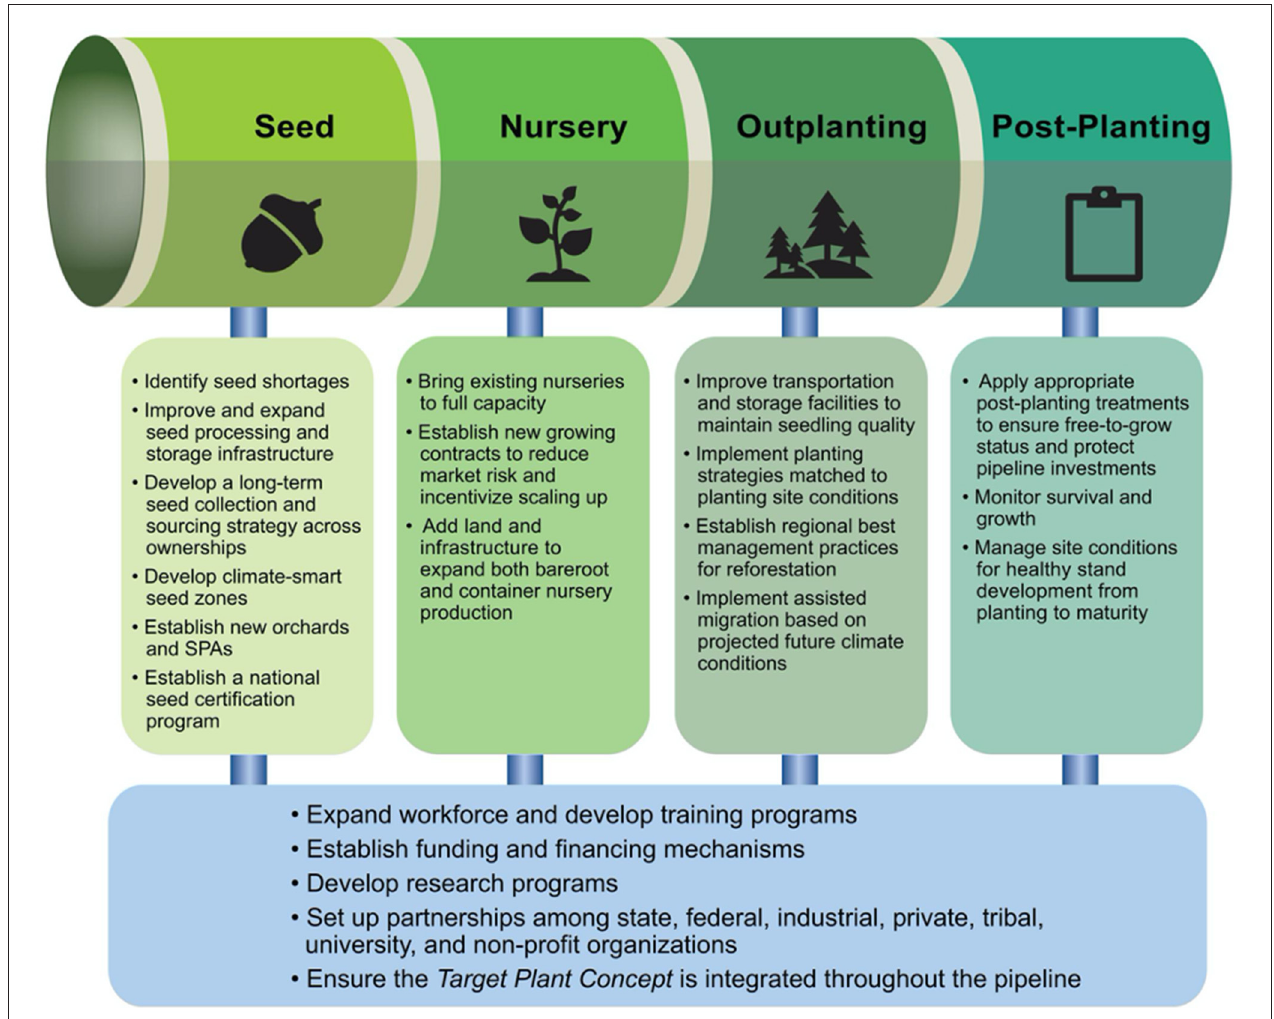
FIGURE 7 | Actions needed to address challenges within the reforestation pipeline in order to implement an ambitious reforestation